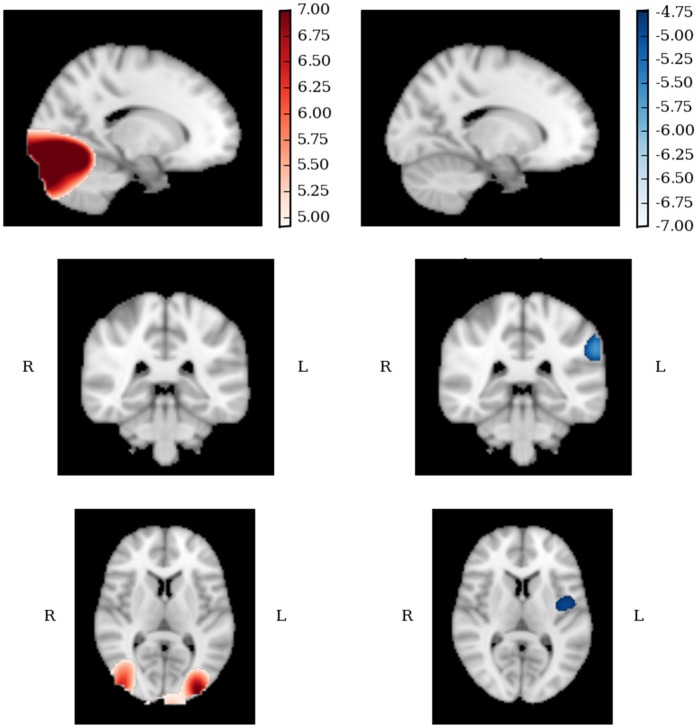
The gamma band response (30–80 Hz), 250–450
ms, in TD (left) and ASD (right) participants. Red  =  maxima, blue  =  minima. P<.05 for all highlighted voxels. Slice shown MNI: −16, −56, 8.